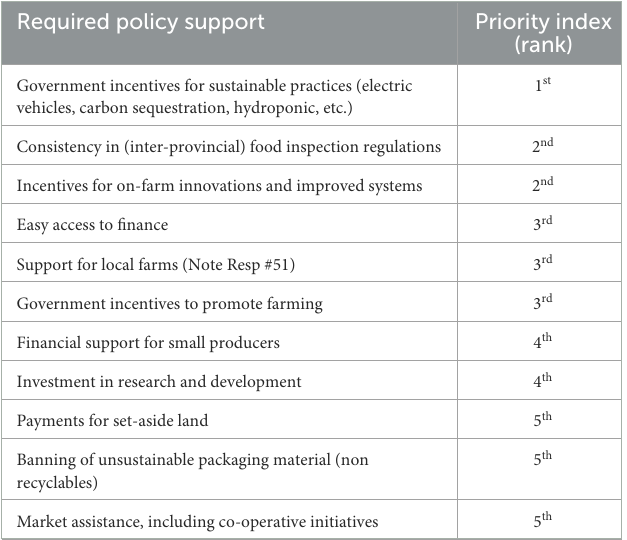
TABLE 8 Potential policy interventions to promote sustainable practices in Atlantic Canada SFSCs. Required policy support Priority index